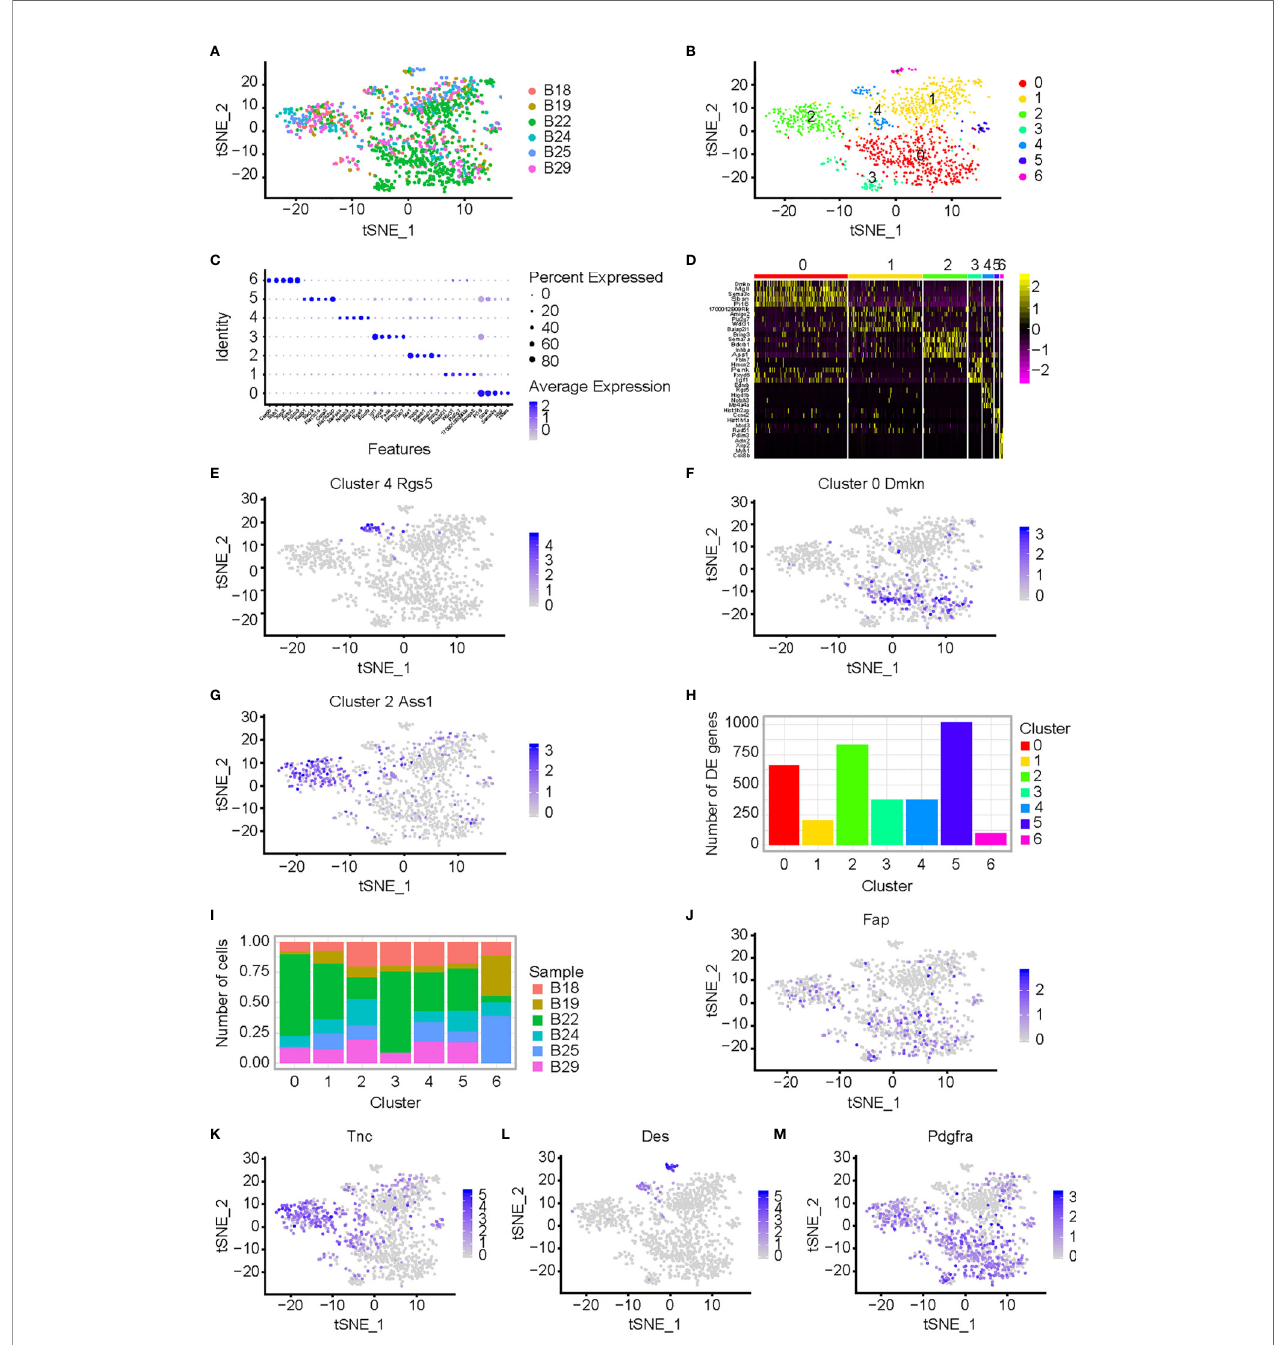
FIGURE 2 | CAF analysis in mouse CT26 tumor with BCL9 depletion. (A) Single cell RNA-seq of CT26 tumor cells; t-SNE of the six samples from CT26 tumor cells, which were treated by shRNA-BCL9 or NT-shRNA, were collected. The plasmid with shRNA-BCL9 was constructed and transfected into CT26 cells. The CT26 cells which transfected NT-shRNA were used as control. Six samples included: B18 (NT-shRNA sample 18), B19 (NT-shRNA sample 19), B22 (NT-shRNA sample 22), B24 (BCL9-shRNA sample 24), B25 (BCL9-shRNA sample 25), and B29 (BCL9-shRNA sample 29). (B) Seven distinct cell clusters, named as C0 – C6 based upon their total cell numbers, expressed unique transcriptional pro fi les and marker gene. (C) Bubble plots show signi fi cant genes with high expression of the known markers of major cell types. (D) Heatmap shows signi fi cant difference in gene expression among seven clusters. (E – G) Expression of marker genes for the cell types de fi ned above each cluster; Rgs5 , Dmkn , and Ass1 , highly expressed in clusters 4, 0, and 2, respectively. (H, I) Different clusters present difference in cell numbers and genes between clusters 0, 1, 2, 3, 4, 5, and 6. (J – M) Expression of CAF marker genes for the cell types de fi ned above each cluster; Fap , Tnc , Des , and Pdgfra , highly expressed in clusters 2, 0, and 4, respectively. Wilcoxon rank sum test was used for statistical